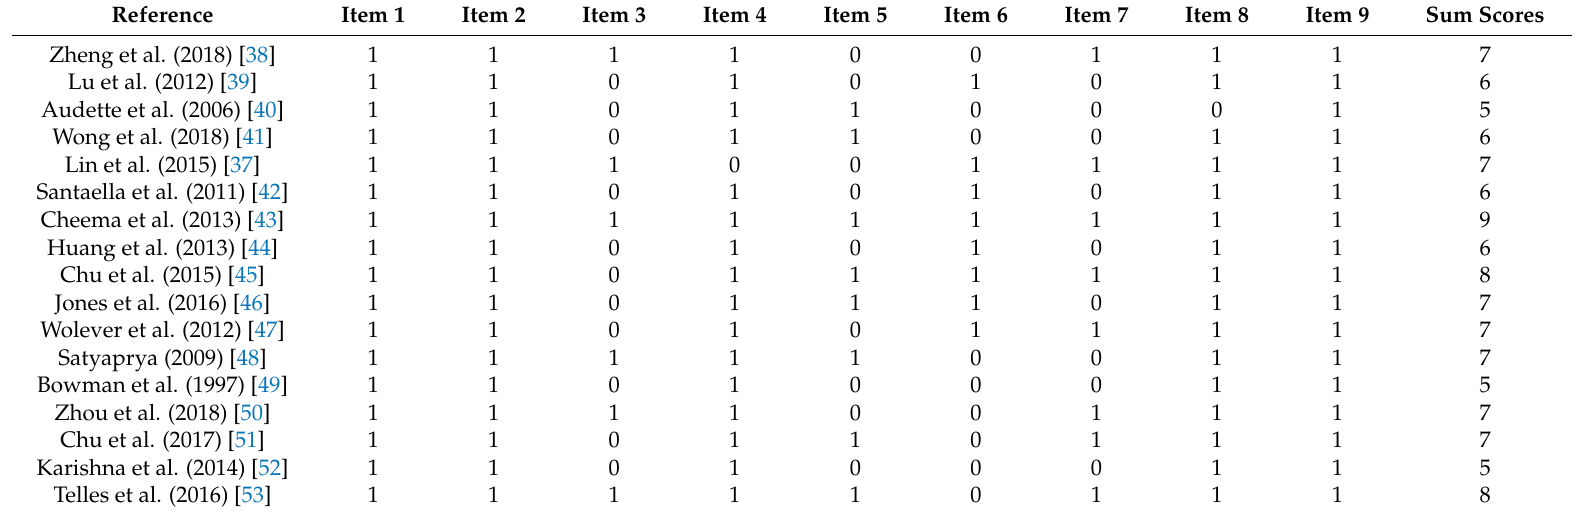
Table 2. Study quality